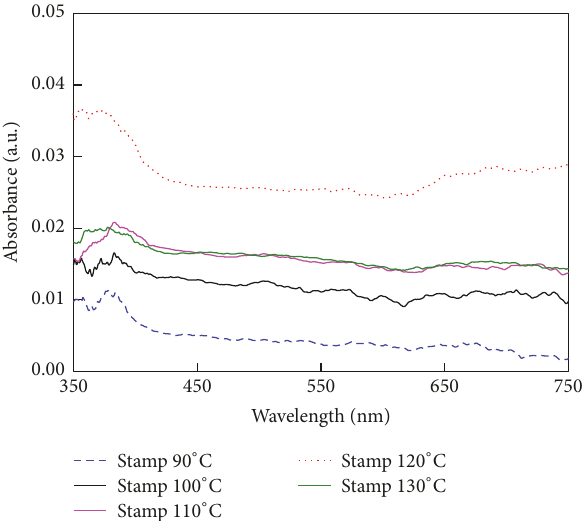
Figure 3: Absorption spectra of TPBi film in different stamping temperatures.